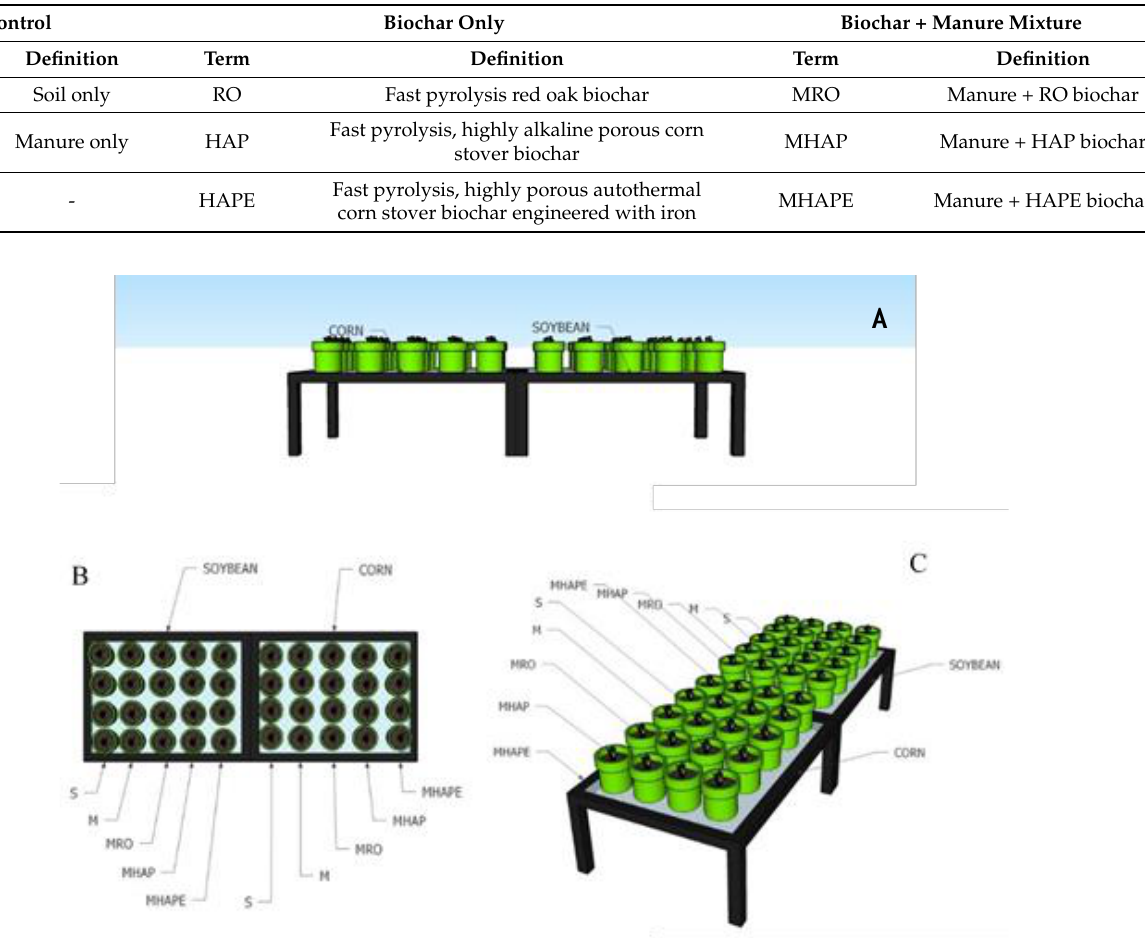
Figure 2. Experimental setup schematic; ( A ) front, ( B ) top, and ( C ) perspective view.